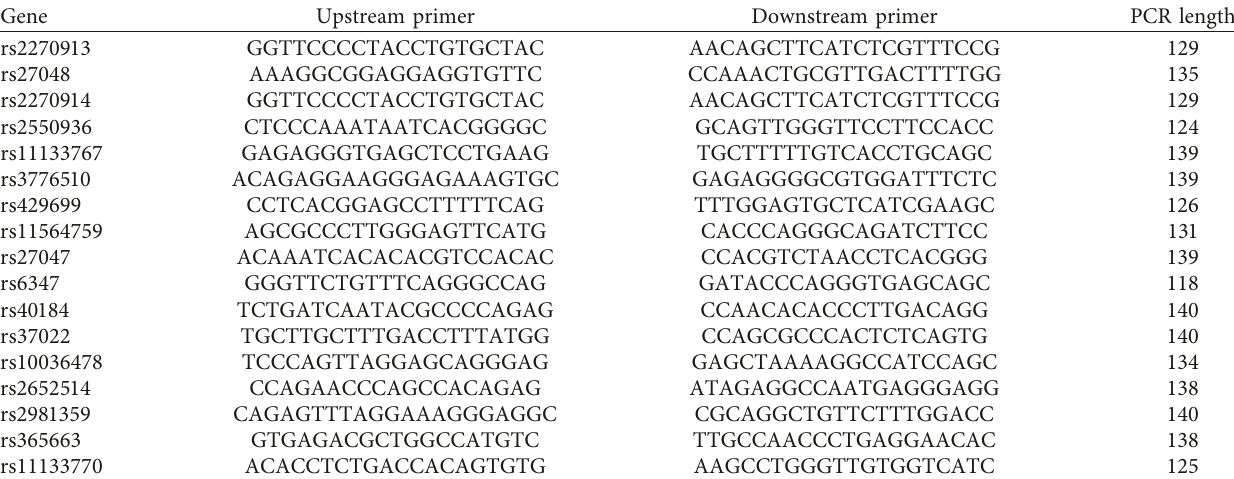
Table 1: Primer of single-nucleotide polymorphisms of SLC6A3.